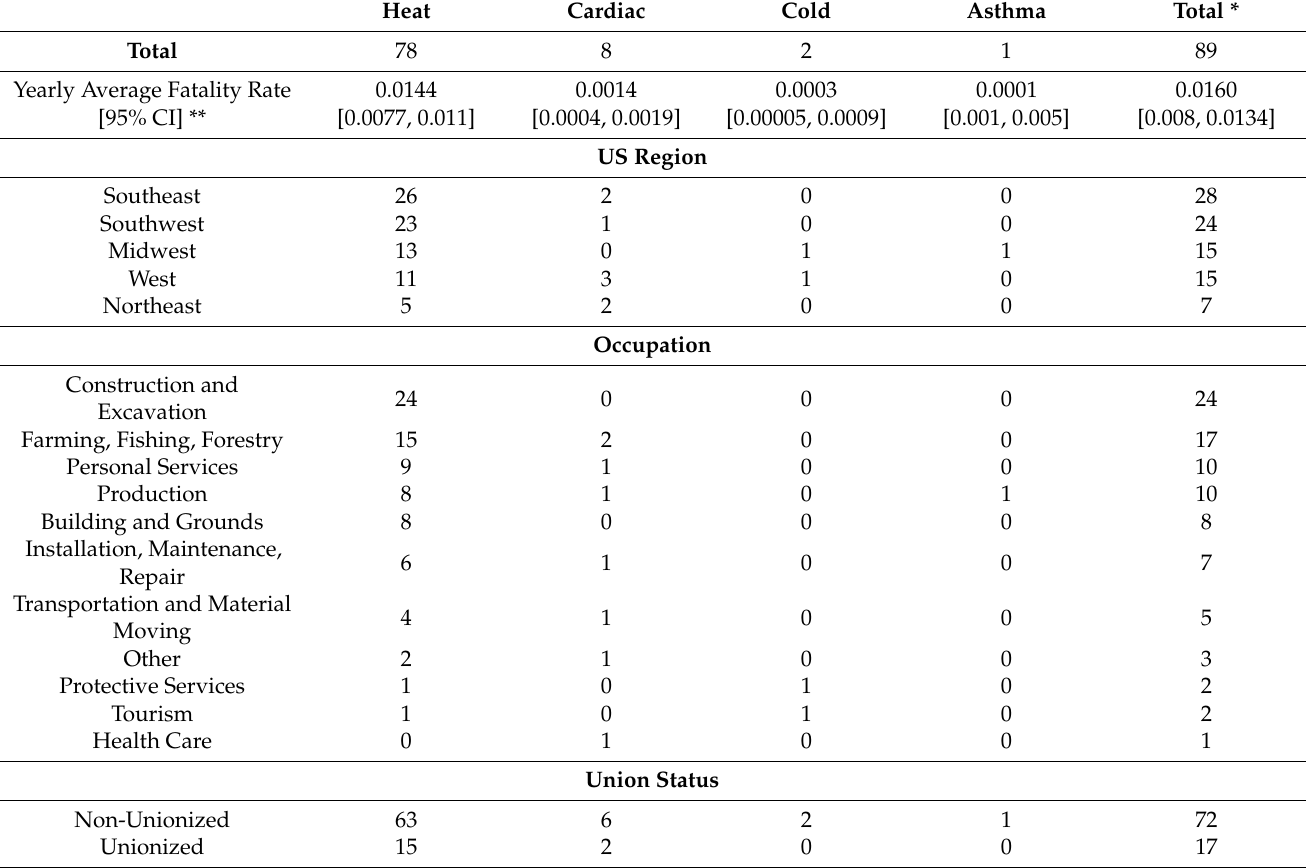
Table 4. Exertion-related fatality rates and summary statistics in OSHA Fatality Inspection Database